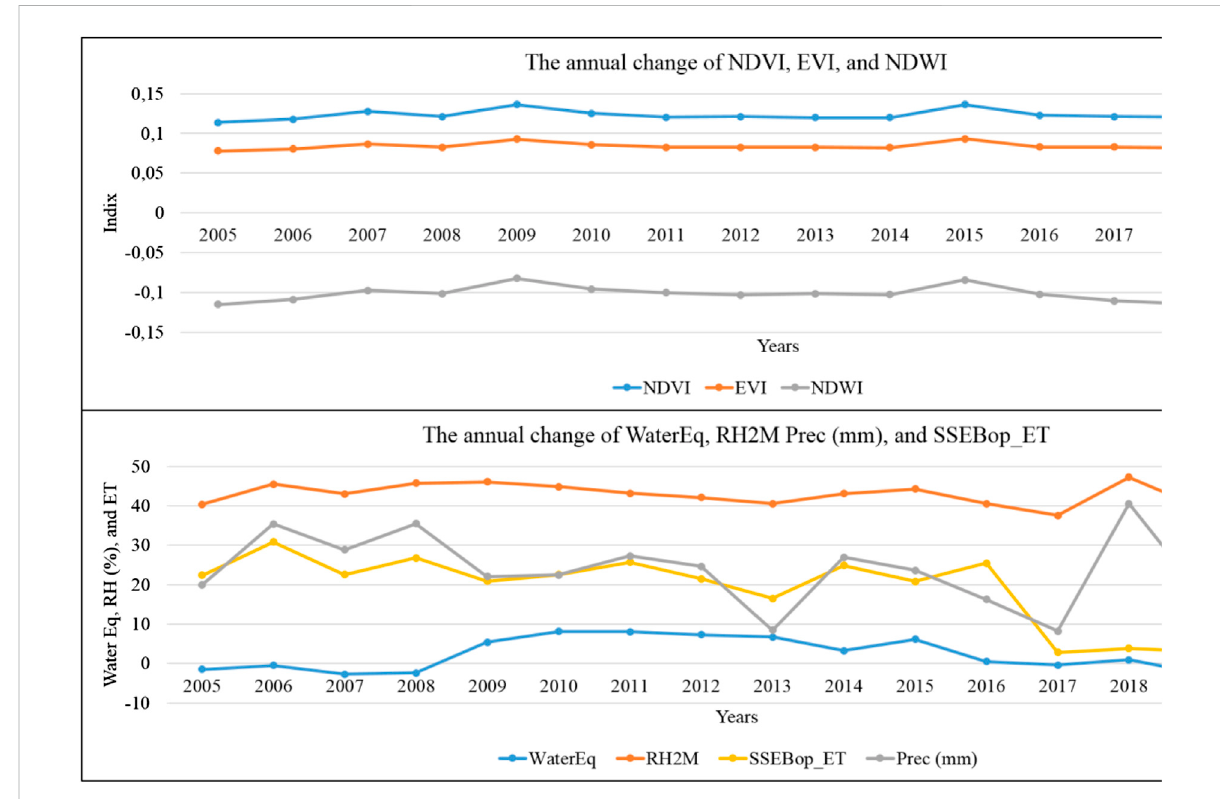
FIGURE 5 The annual changes from 2005 to 2020 (The average of the 12 months of each